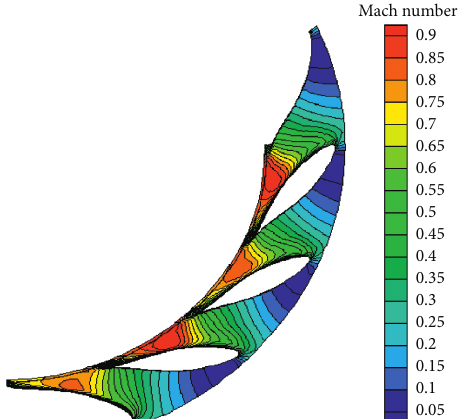
Figure 25: Opening − 6 ° .